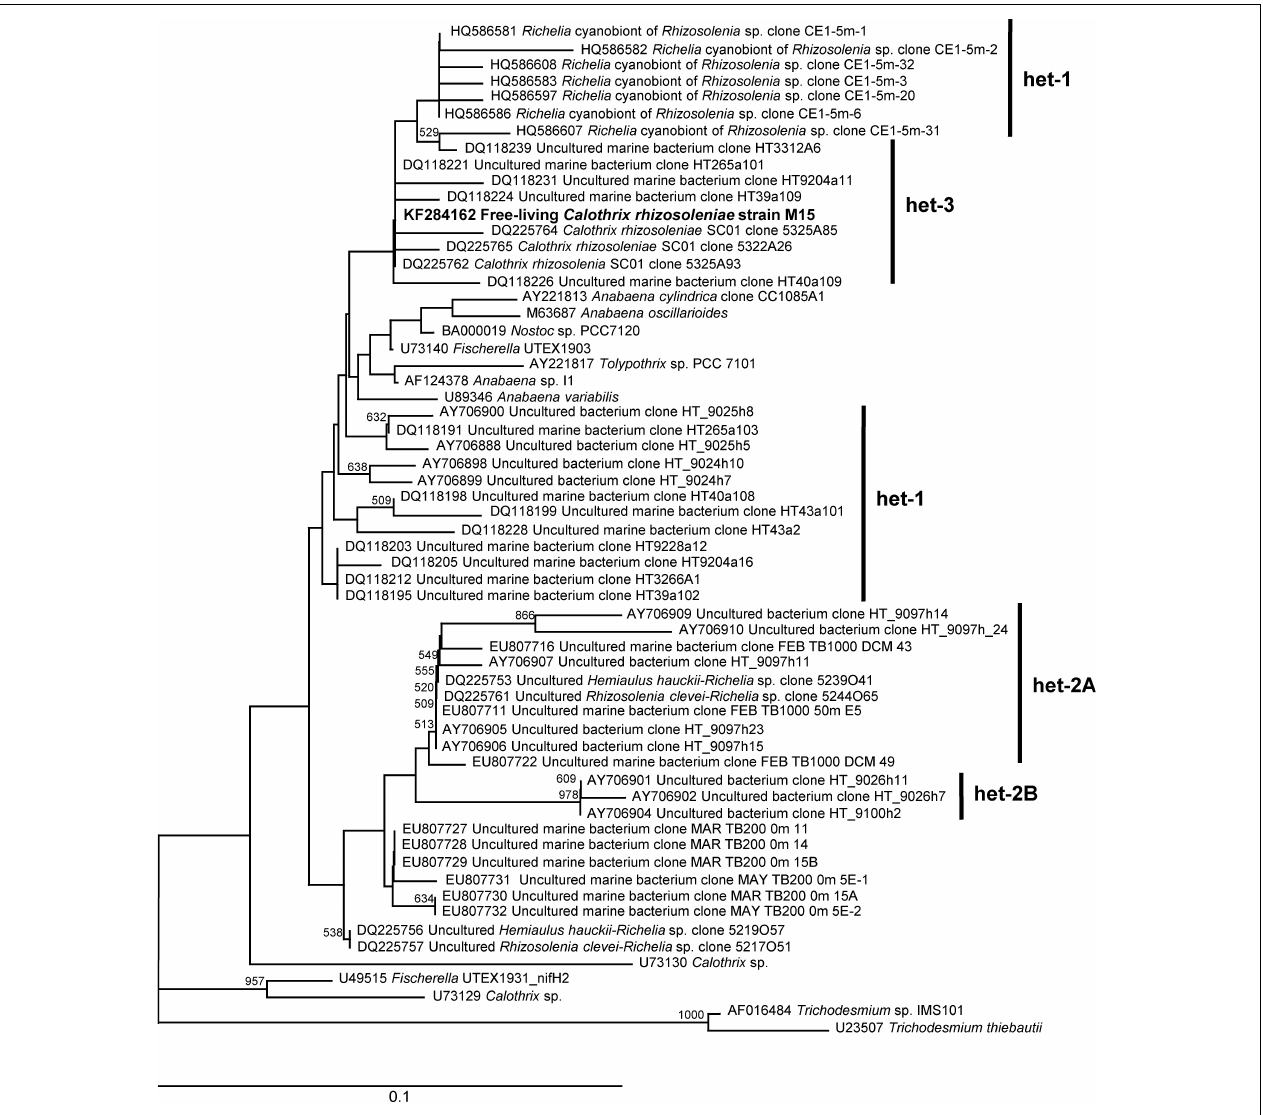
FIGURE 3 | Neighbor-joining phylogenetic tree for partial nifH amino acid sequences. The sequence obtained from Calothrix rhizosoleniae strain M15 (KF284162) is indicated in boldface. The bootstrap values ( > 500) are indicated at the nodes. The scale bar represents 0.1 substitutions per site, and the nifH genes of Trichodesmium sp. IMS 101 (AF016484) and Trichodesmium thiebautii (U23507) were used as the